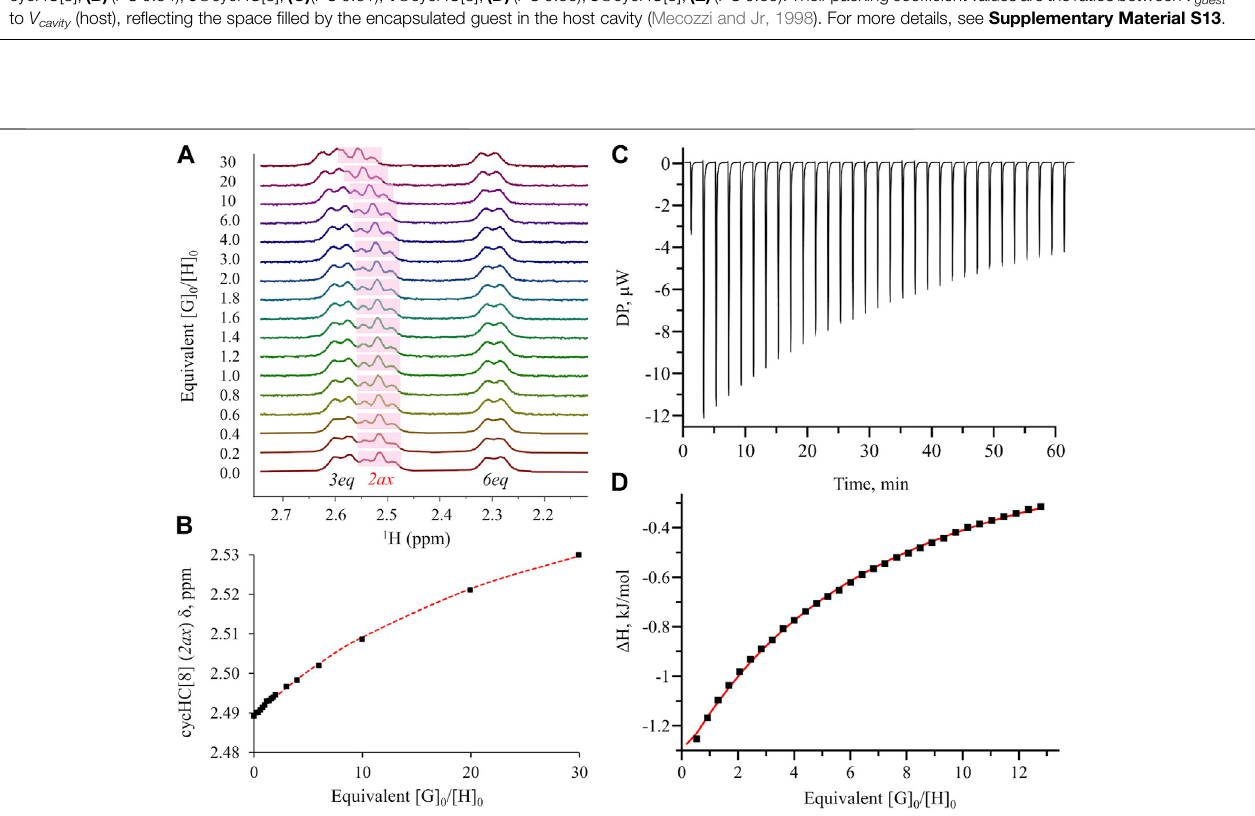
FIGURE 3 | 1 H NMR and ITC titration for cycHC[8] binding with 1 (A) spectra for NMR titration in CD 3 OD; (B) binding isotherm for NMR titration assuming the 1:1 binding model; (C) raw thermogram for ITC measurement in the CH 3 OH:H 2 O (50:50) mixture; (D) binding isotherm for ITC measurement using the “ one set of sites ” model. More details are provided in Supplementary Material S16 – S31